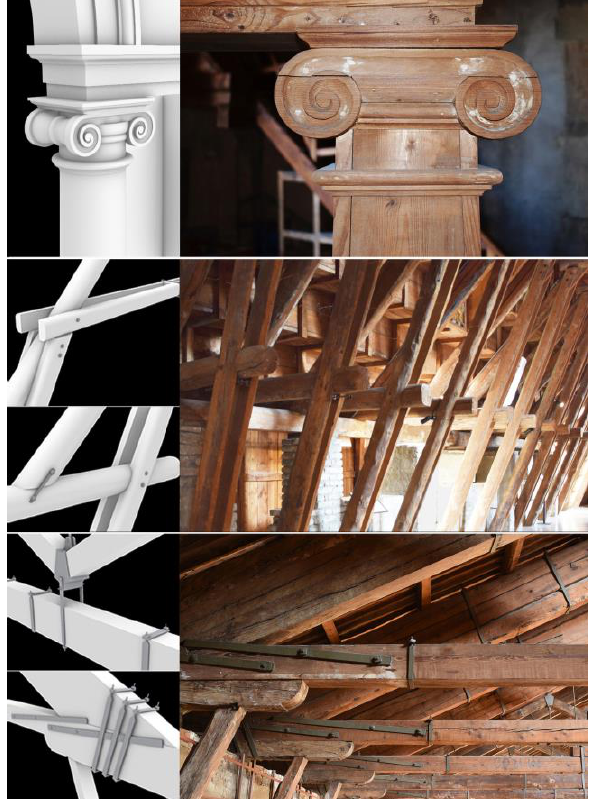
Figure 4 . Photographs and digital reconstructions of some classes of elements present in the Farnese Theatre in Parma.